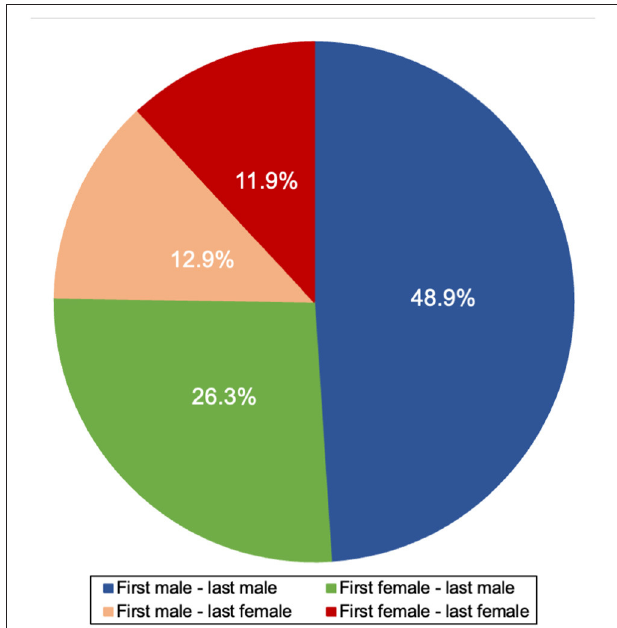
FIGURE 6 | First and last author collaboration